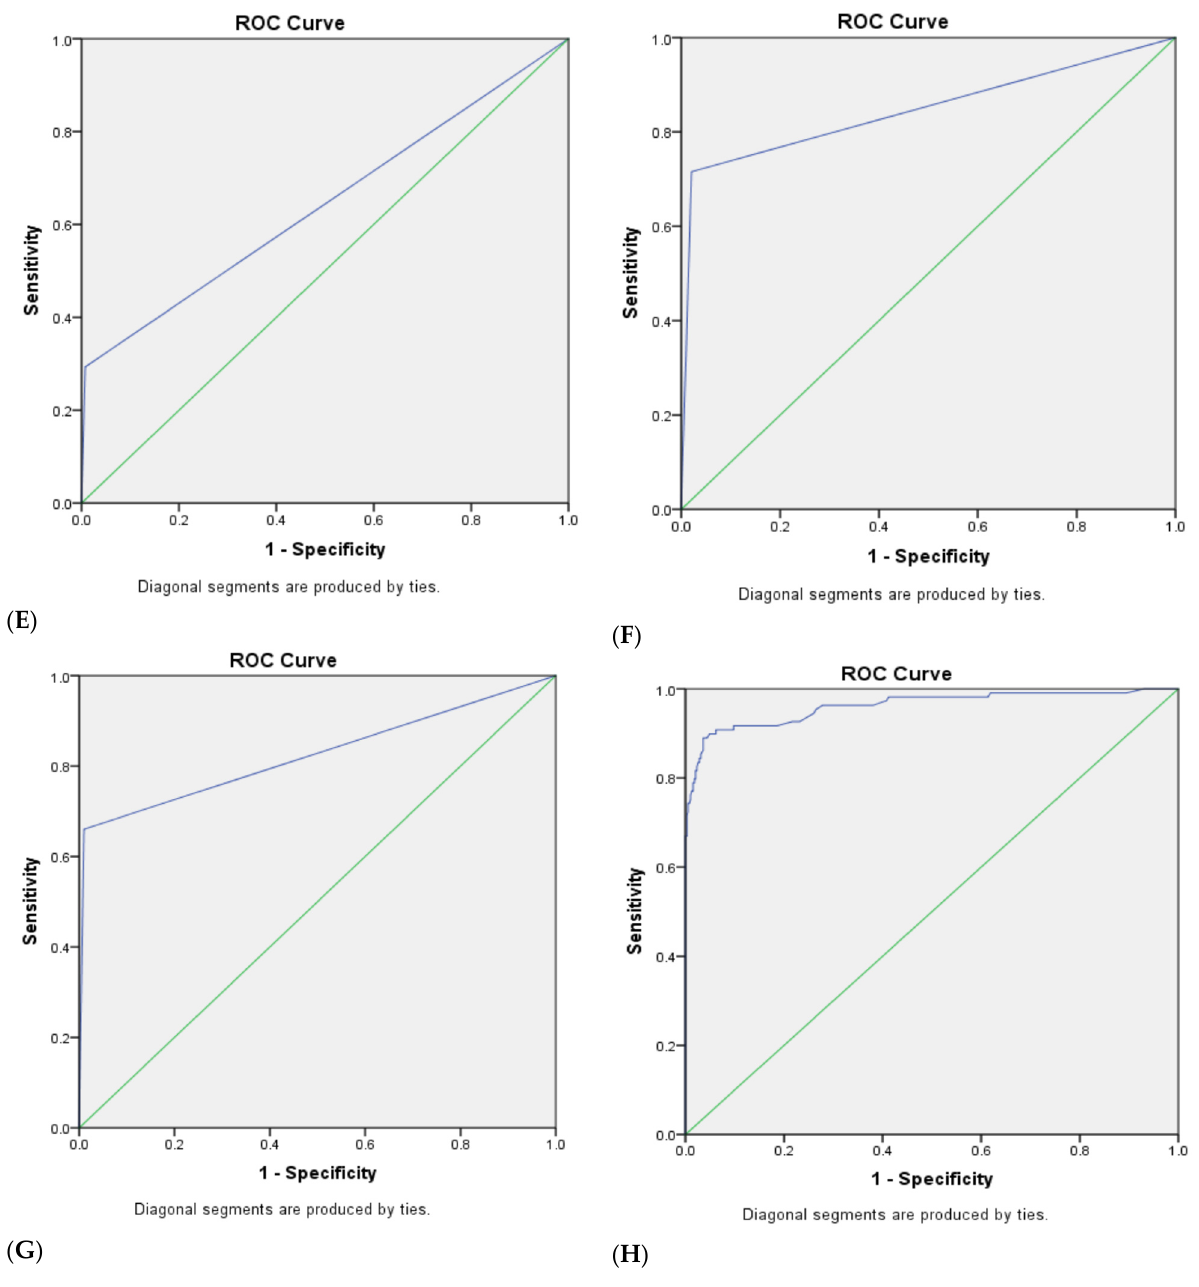
Figure 3. The ROC curves of various malignant ultrasound signs and their combination. ( A ) The ROC curve of endometrial thickness malignant signs; AUC: 0.826, SE: 0.025, 95% CI (0.777, 0.874). ( B ) The ROC curve of non-uniform endometrial echogenicity malignant signs “ heterogeneous with irregular cysts”; AUC: 0.688, SE: 0.032, 95% CI (0.625, 0.751). ( C ) The ROC curve of endometrial midline appearance malignant signs “not defined”; AUC: 0.732, SE: 0.028, 95% CI (0.677, 0.786). ( D ) The ROC curve of endometrial–myometrial junction malignant signs “interrupted or not defined”; AUC: 0.898, SE: 0.021, 95% CI (0.856, 0.939). ( E ) The ROC curve of intracavitary fl uid malignant signs “ground glass or mixed echogenicity”; AUC: 0.643, SE: 0.033, 95% CI (0.577, 0.709). ( F ) The ROC curve of color score malignant signs “3~4 points”; AUC: 0.847, SE: 0.027, 95% CI (0.795, 0.900). ( G ) The ROC curve of vascular pattern malignant signs: multiple vessels (focal origin) or multiple vessels (multifocal origin); AUC: 0.825, SE: 0.028, 95% CI (0.770, 0.881). ( H ) The ROC curve of combination of multiple ultrasonic malignant signs; AUC: 0.962, SE: 0.012, 95% CI (0.938, 0.986).